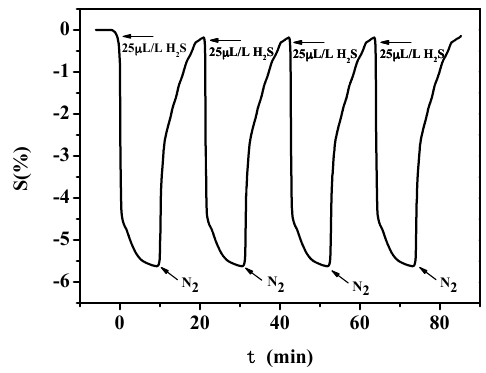
Figure 9. Reversibility curve of PANI-SSA sensors to H 2 S.